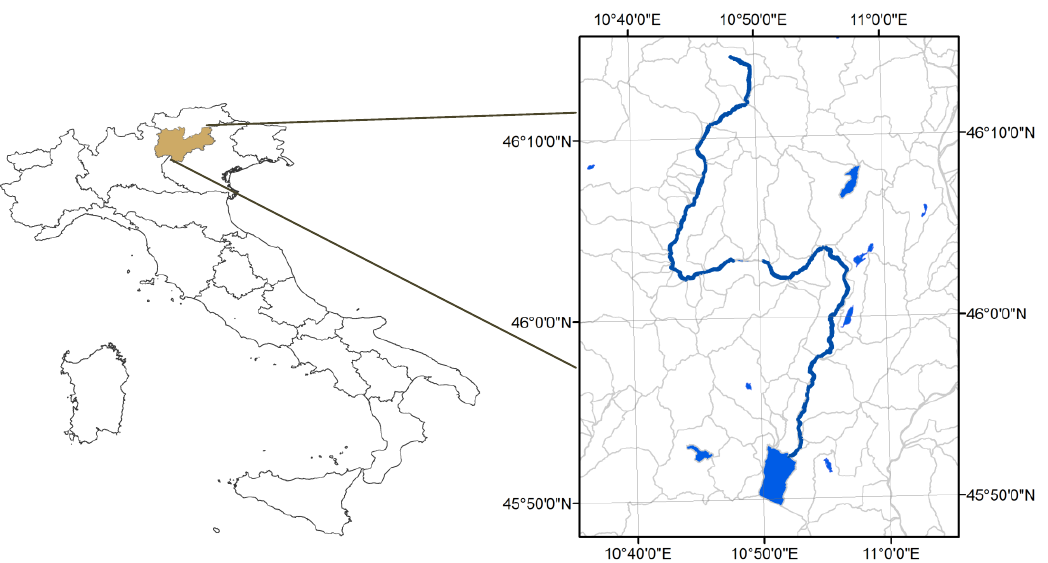
Figure 1. Sarca river located in northeast of